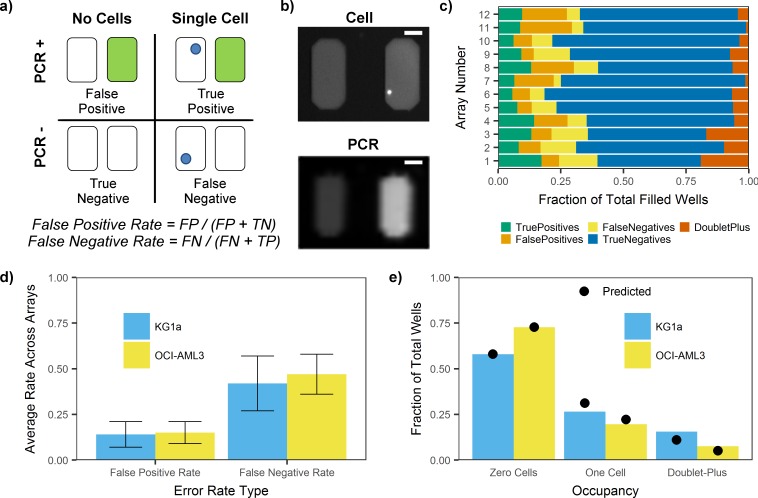
Method quality statistics.(a) Based on cell and endpoint PCR imaging, wells can be categorized as true positive (TP), false positive (FP), false negative (FN), and true negative (TN). These counts allow us to calculate a false positive and false negative rate for each array to assess performance. (b) Images show two wells of the SD chip before (top) and after (bottom) PCR. A single OCI-AML3 cell was identified in the right well, and the well was PCR positive after thermalcycling. The scale bar is 100 μm. (c) For the 12 SD chip arrays used for genotyping single OCI-AML3 cells, colored bars represent the fraction of filled wells that fall into each category described in panel A. Wells with more than one cell (doublet+) are also reported. (d) False positive rates and false negative rates were calculated for each OCI-AML3 or KG1a single-cell genotyping SD chip array. The average rate between arrays is reported for arrays with KG1a cells (blue) and arrays with OCI-AML3 cells (yellow). Scale bar represents standard deviation (N = 12 arrays with OCI-AML3 cells, N = 4 arrays with KG1a cells). (e) The fraction of wells containing no cells, one cell, or more than one cell (doublet+) was quantified from images of cells in arrays of the SD chip. Using Poisson’s equation, we calculated a predicted number of wells (black circle) that would be expected to contain one cell or more than one cell using the number of wells containing zero cells. For arrays containing either KG1a cells (blue) or OCI-AML3 cells (yellow), the actual number of wells with one cell was below the predicted number while the number of multiple cell wells was higher.